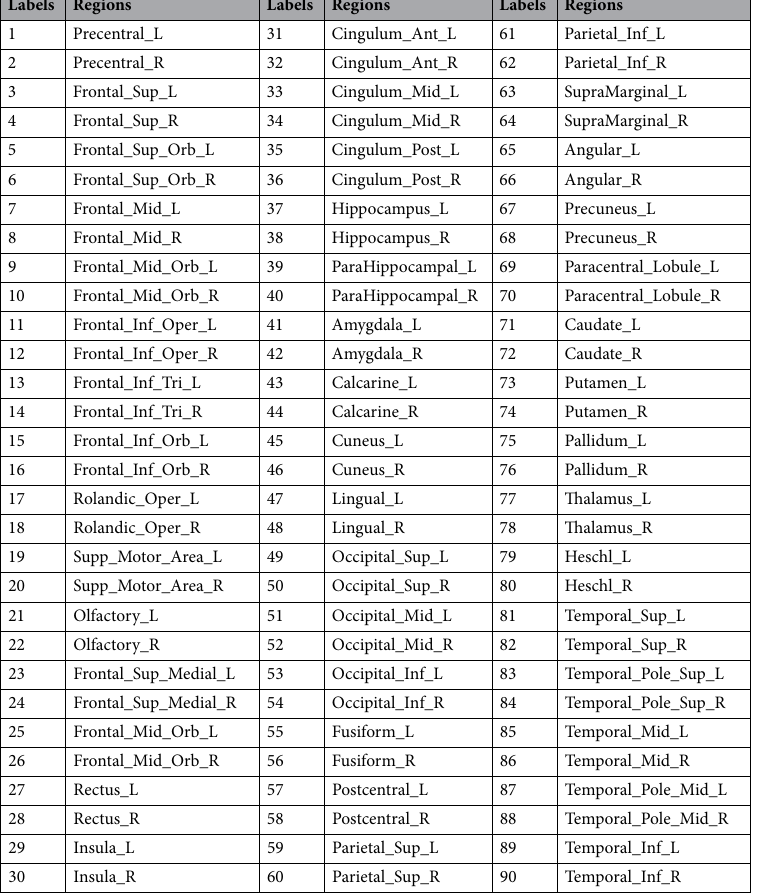
Table 2. Labels of the ninety brain regions matching the AAL